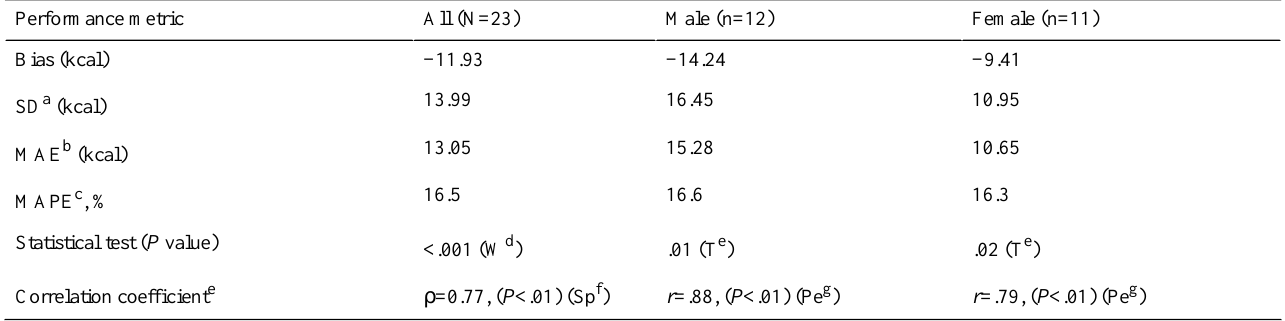
Table 5. Statistical error analysis of energy expenditure during light intensity.